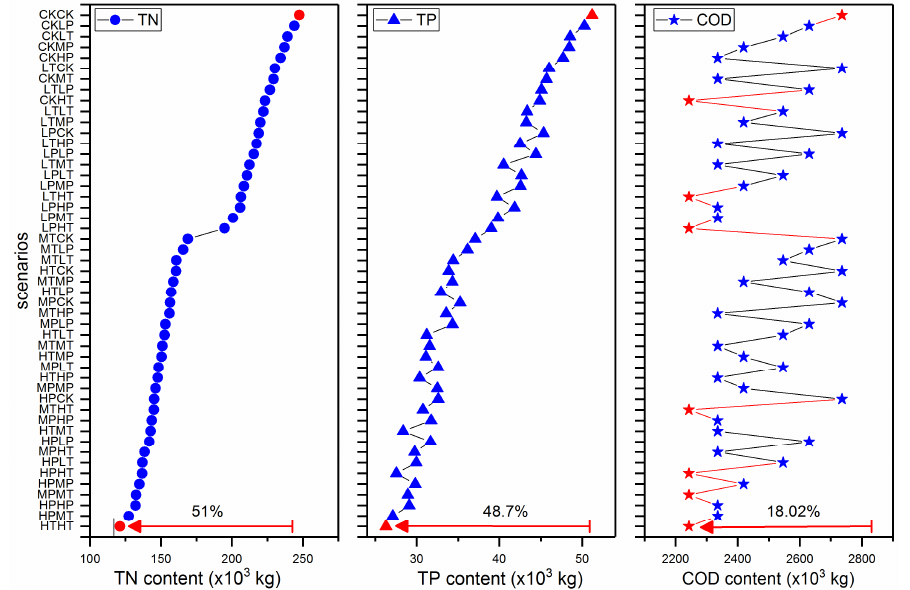
Figure 6. Pollutant discharge and profit of agricultural households and factories in different scenarios. CK represents the control group; LT, MT and HT represent low tax, medium tax, and high tax, respectively; LP, MP and HP represent low offset, medium offset, and high offset, respectively. The first two letters of the scenario labels represent the policy of agricultural household agents, and the others represent the policy of factory agents.